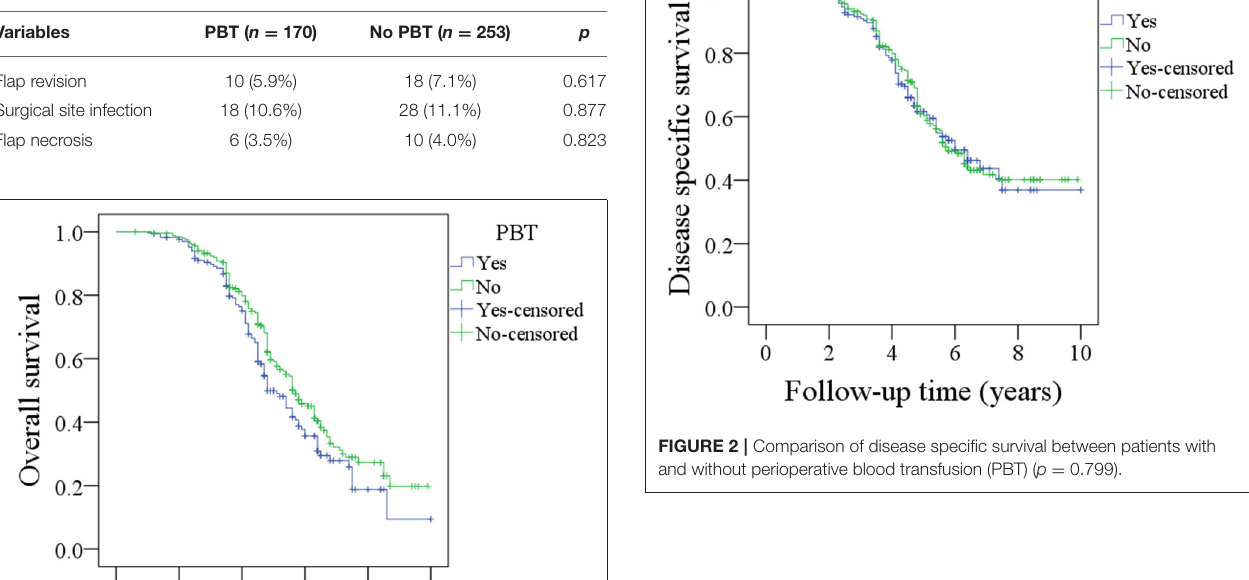
TABLE 2 | Comparison of short term outcome in patients with and without perioperative blood transfusion (PBT).